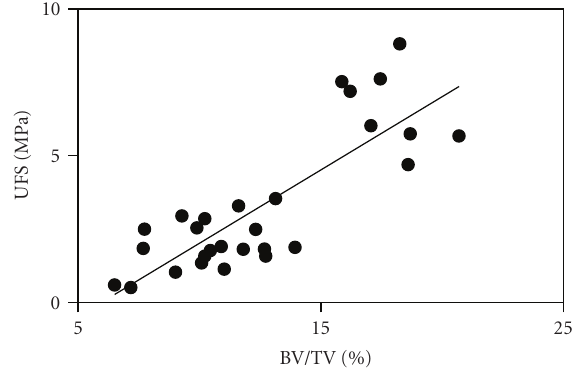
Figure 3: Scatter plot of BV/TV versus UFS (bone strength), showing a statistically significant relationship ( r 2 = 0.68; P <